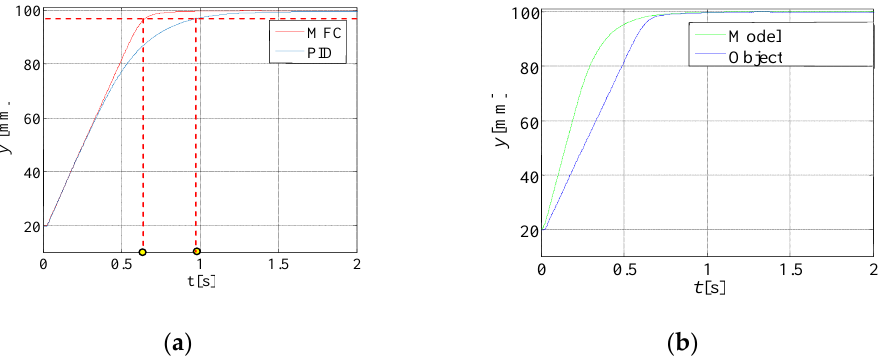
Figure 14. ( a ) Comparison of MFC i PID controller (red line — settling time); ( b ) piston rod displacement for MFC regulator (object) and EHSD model in main controller loop ( p 0 = 4 MPa, F L = 697 N).